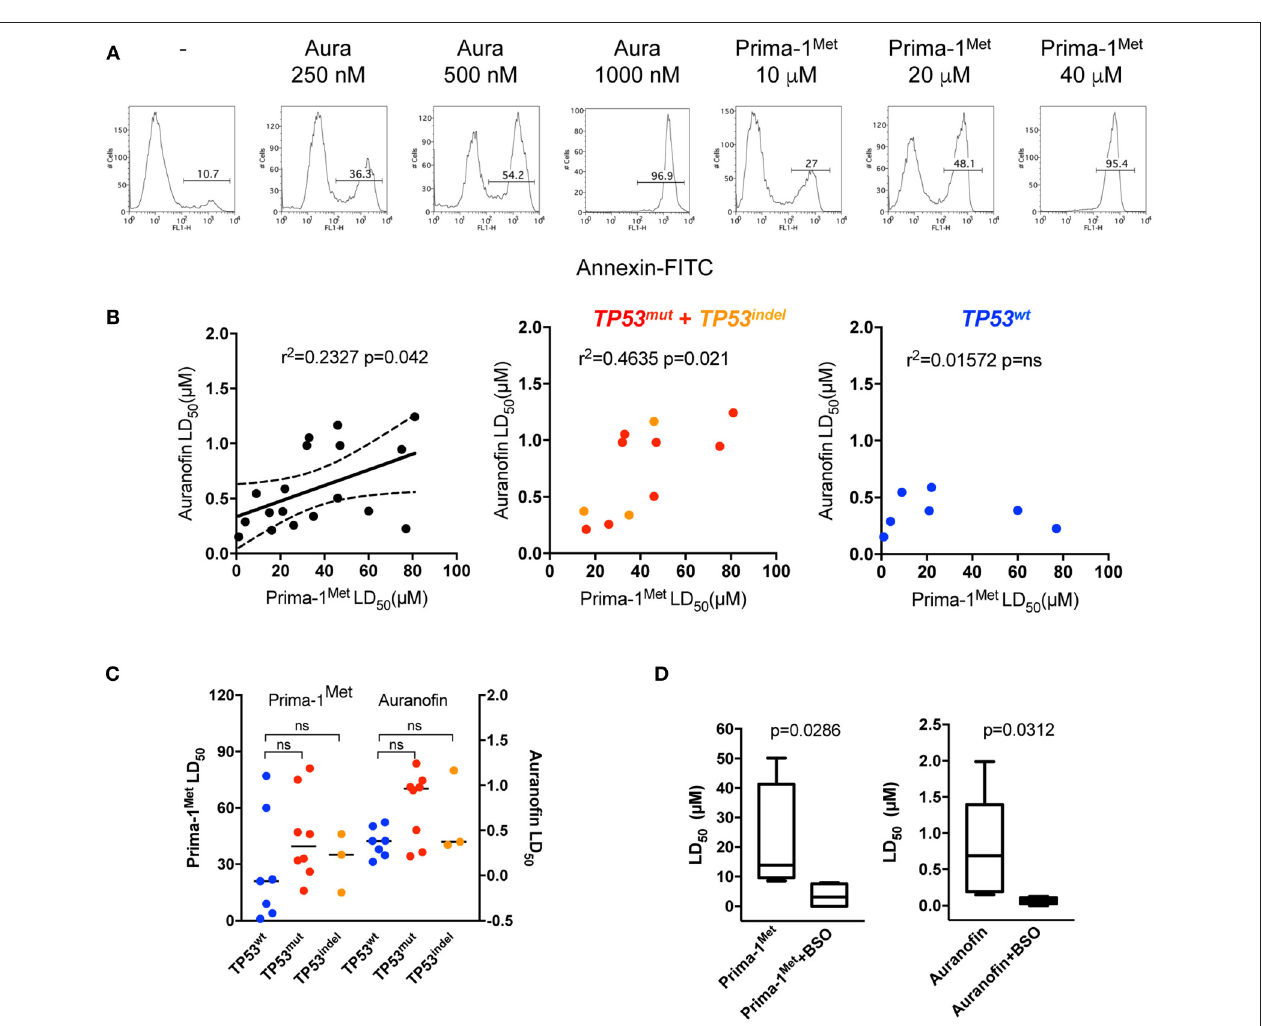
FIGURE 1 | HMCLs were similarly sensitive to Prima-1 Met and to auranofin. (A) OMP2 cells (500 000/ml) were incubated with or without (-) increasing concentrations of auranofin or Prima-1 Met for 2 days as indicated in the figure, and cell death was assessed by Annexin V staining. (B) The LD 50 (lethal dose 50) values of auranofin were plotted against the LD 50 values of PRIMA-1 Met in 18 HMCLs (left). The graphs of the middle and right panels represent the correlations between the two drugs in TP53 Abn and TP53 wt HMCLs, respectively. The statistical analyses were performed using the Pearson test. (C) The LD 50 values of auranofin and PRIMA-1 Met were analyzed according to TP53 wt , TP53 mut , and TP53 indel statuses. The statistical analyses were performed using the Mann-Whitney test. (D) HMCLs were incubated with increasing concentrations of each drug with or without BSO (500 µ M) for 2 days. Cell death was assessed by Annexin V staining. The statistical analyses were performed using the Wilcoxon matched-pairs signed-rank